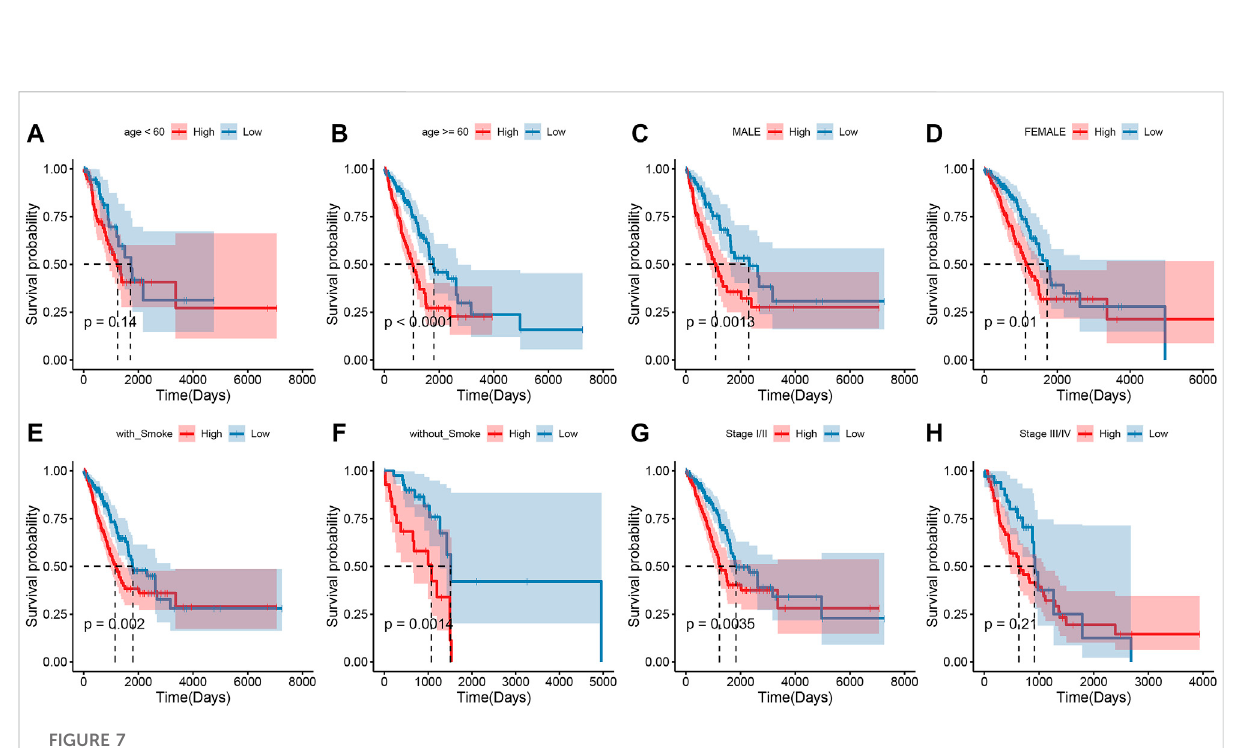
FIGURE 7 Survival outcomes of patients with different clinical characteristics in the high and low groups (A – H)